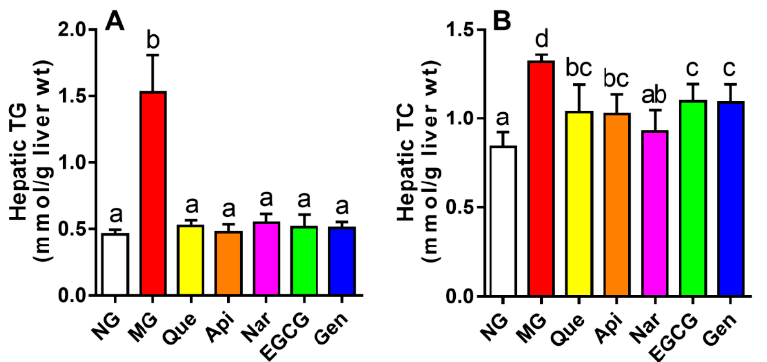
Figure 3. Effect of five kinds of flavonoids on hepatic lipid profiles: ( A ) hepatic total triglyceride level; ( B ) hepatic total cholesterol level. Values are expressed as the mean ± SD ( n = 10). Labeled means without a common letter differ ( p < 0.05). NG, normal group; MG, model group; Que, quercetin; Api, apigenin; Nar, naringenin; EGCG, epigallocatechin gallate; Gen, genistein; TG, total triglyceride level; TC, total cholesterol level.